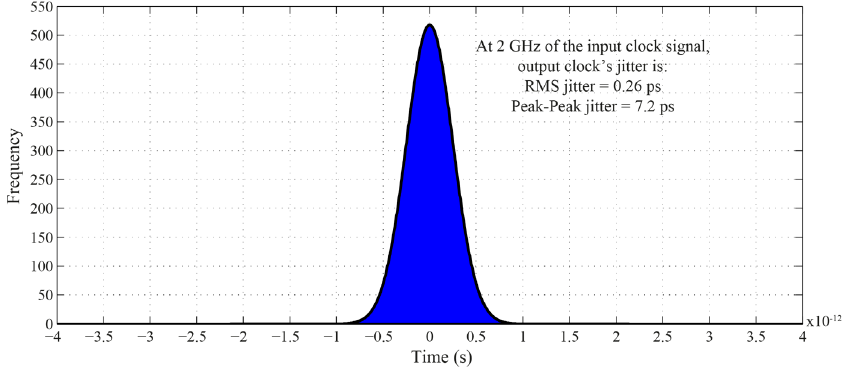
Figure 12. DLL output jitter histogram.